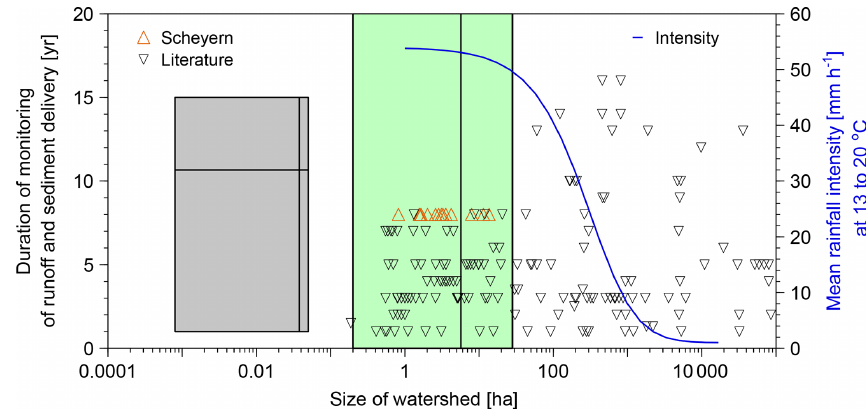
Figure 1. Watershed size and duration of continuous measurements of runoff and sediment delivery for watershed studies taken from literature since 1970 (black triangles) in comparison with the Scheyern dataset (red triangles). The 99.5%-range of field sizes in Germany is shaded in green; the vertical line denotes the average (taken from Auerswald et al., 2018). The approximate range of plot studies with natural rain is shaded in grey; the vertical and horizontal lines denote the average plot size and the average study duration (taken from Cerdan et al., 2010). Watershed studies from literature were (Anderson and Potts, 1987; Baker and Johnson, 1979; Beasley, 1979; Beasley et al., 1986; Becht and Wetzel, 1989; Bingner et al., 1989; Bowie and Bolton, 1972; Brooks et al., 2010; Casali et al., 2008; Chow et al., 1999; Deasy et al., 2011; Dendy, 1981; Dickinson and Scott, 1975; Didone et al., 2017; Diyabalanage et al., 2017; Duvert et al., 2010; Edwards et al., 1993; Evrard et al., 2008; Foster et al., 1980; Garcia-Ruiz et al., 2008; Glendell and Brazier, 2014; Grangeon et al., 2017; Hamlett et al., 1983; Hasholt, 1992; Hasholt and Styczen, 1993; Inoubli et al., 2016; Khanbilvardi and Rogowski, 1984; Kimes and Baker, 1979; McDowell et al., 1984; Mielke, 1985; Mildner and Boyce, 1979; Minella et al., 2018; Monke et al., 1979; Murphree and Mutchler, 1981; Murphree et al., 1985; Mutchler and Bowie, 1979; Nunes et al., 2016; Onstad et al., 1976; Pieri et al., 2014; Porto et al., 2009; Ramos et al., 2015; Ribolzi et al., 2017; Schilling et al., 2011; Sheridan et al., 1982; Sherriff et al., 2015; Simanton and Osborn, 1983; Simanton et al., 1980; Simanton and Renard, 1982; Sith et al., 2017; Sran et al., 2012; Starks et al., 2014; Steegen et al., 2000; Stott et al., 1986; Valentin et al., 2008; Van Oost et al., 2005; Vongvixay et al., 2018; Walling et al., 2001; Zhang et al., 2015; Zuazo et al., 2012). Note that if watershed data appear in several studies, only one study was cited here. Data to calculate the decrease in mean rainfall intensity (blue line) with increasing watershed size were taken from Lochbihler et al. (2017), who analysed the rainfall intensity for the 1000 largest rainfall events of a 9 year period (at 13 to 20 ◦ C; in the Netherlands); for this figure the centre of the rainfall cell is assumed to be located in the middle of the respective